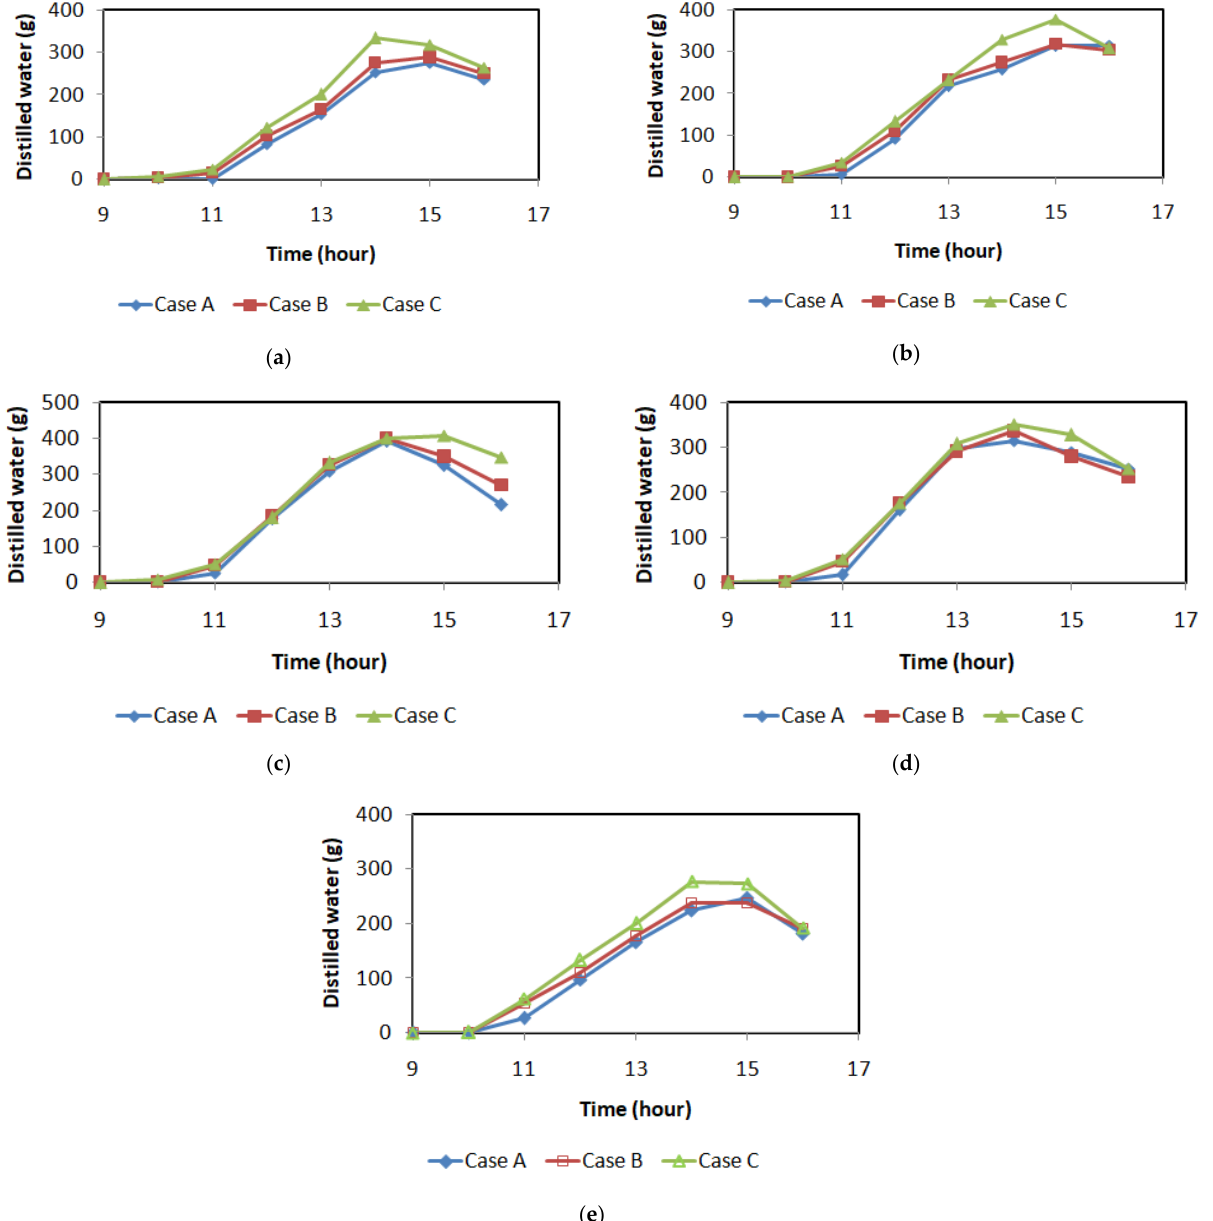
Figure 6. Amount of distilled water obtained from experiment for five days: ( a ) Day 1, ( b ) Day 2, ( c ) Day 3, ( d ) Day 4, and ( e ) Day 5.